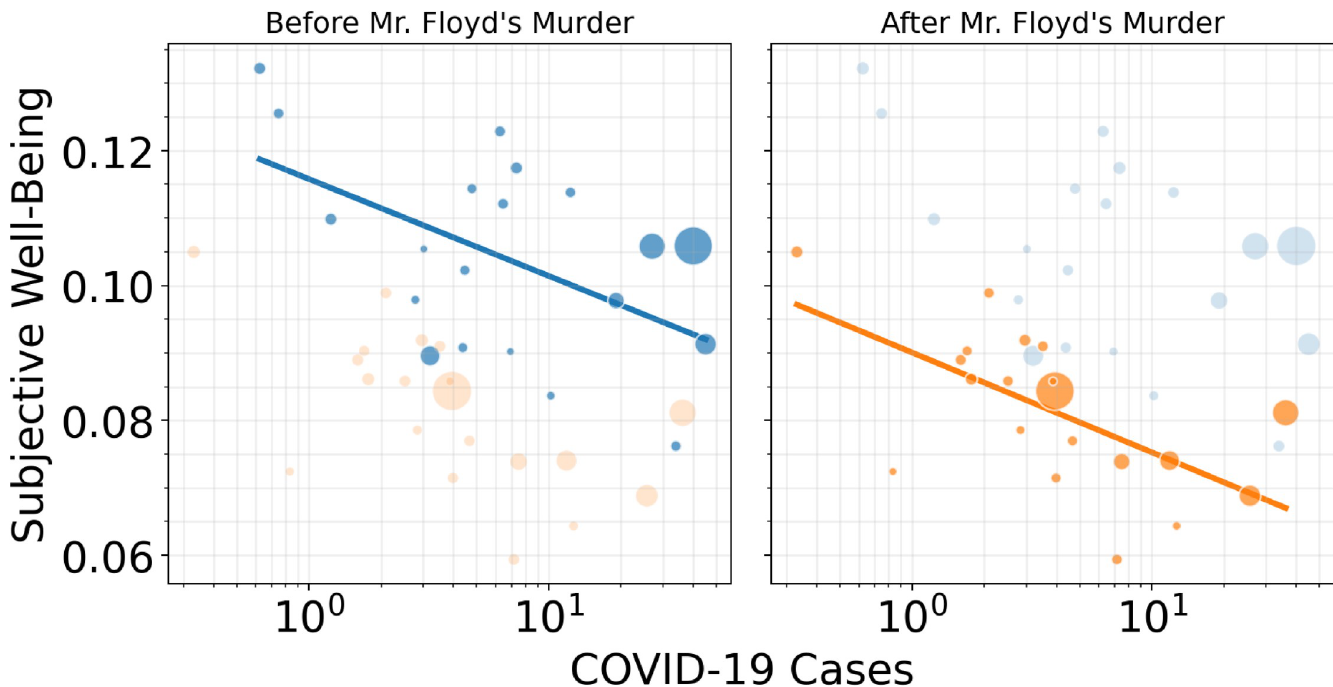
Fig 3. Average VADER score relative to COVID-19 cases highlighted before (blue) and after Mr. Floyd’s murder (orange) with OLS linear fit. The size of each bubble indicates the relative city size (population). Although overall SWB decreased after Mr. Floyd’s murder, as indicated by a downward shift in the regression line, the linear relationship between COVID-19 and SWB remains